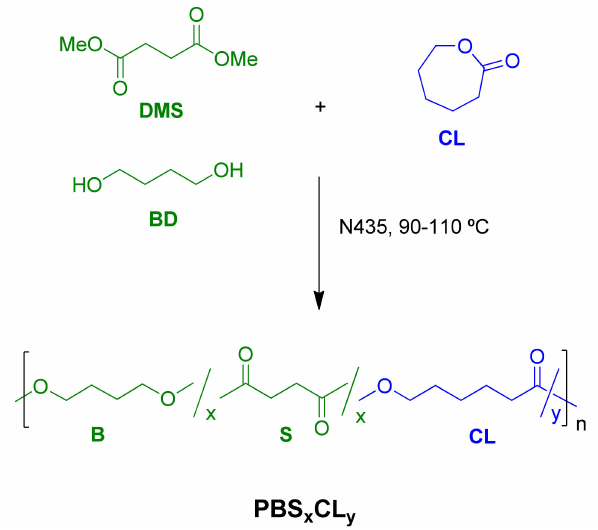
Figure 1. Synthetic route to PBS x CL y copolyesters.